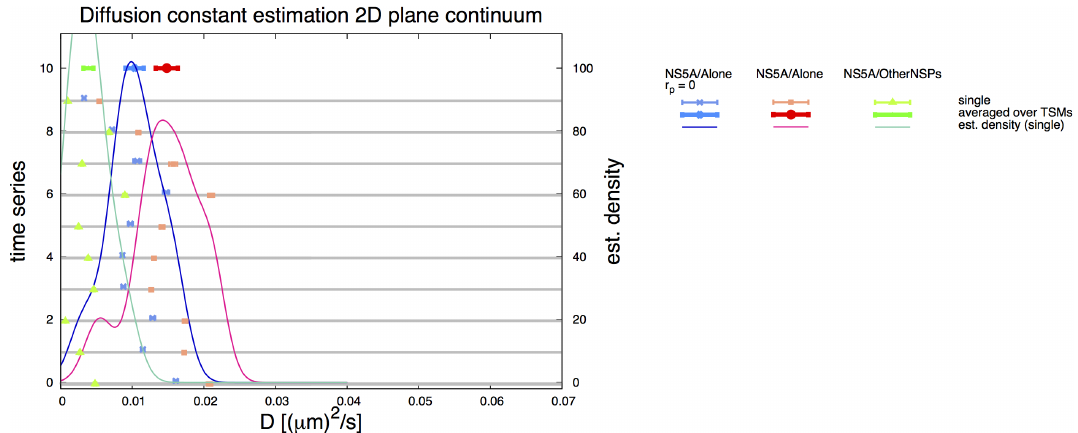
Figure A2. Classical FRAP analysis based upon the 2D computations explained in Section 3.6: Averages for diffusion constant estimation D ns5a —analyzed separately for NS5A/Alone (red— D A NS5A/OtherNSPs (green— D N ) as well as for NS5A/Alone setting r p = 0 (blue— D A ns5a assuming that the measurement process induces no intensity reduction. Thin points and error bars axis). Aggregating over all TMS yields distributions (continuous lines, scale shown on right y axis).